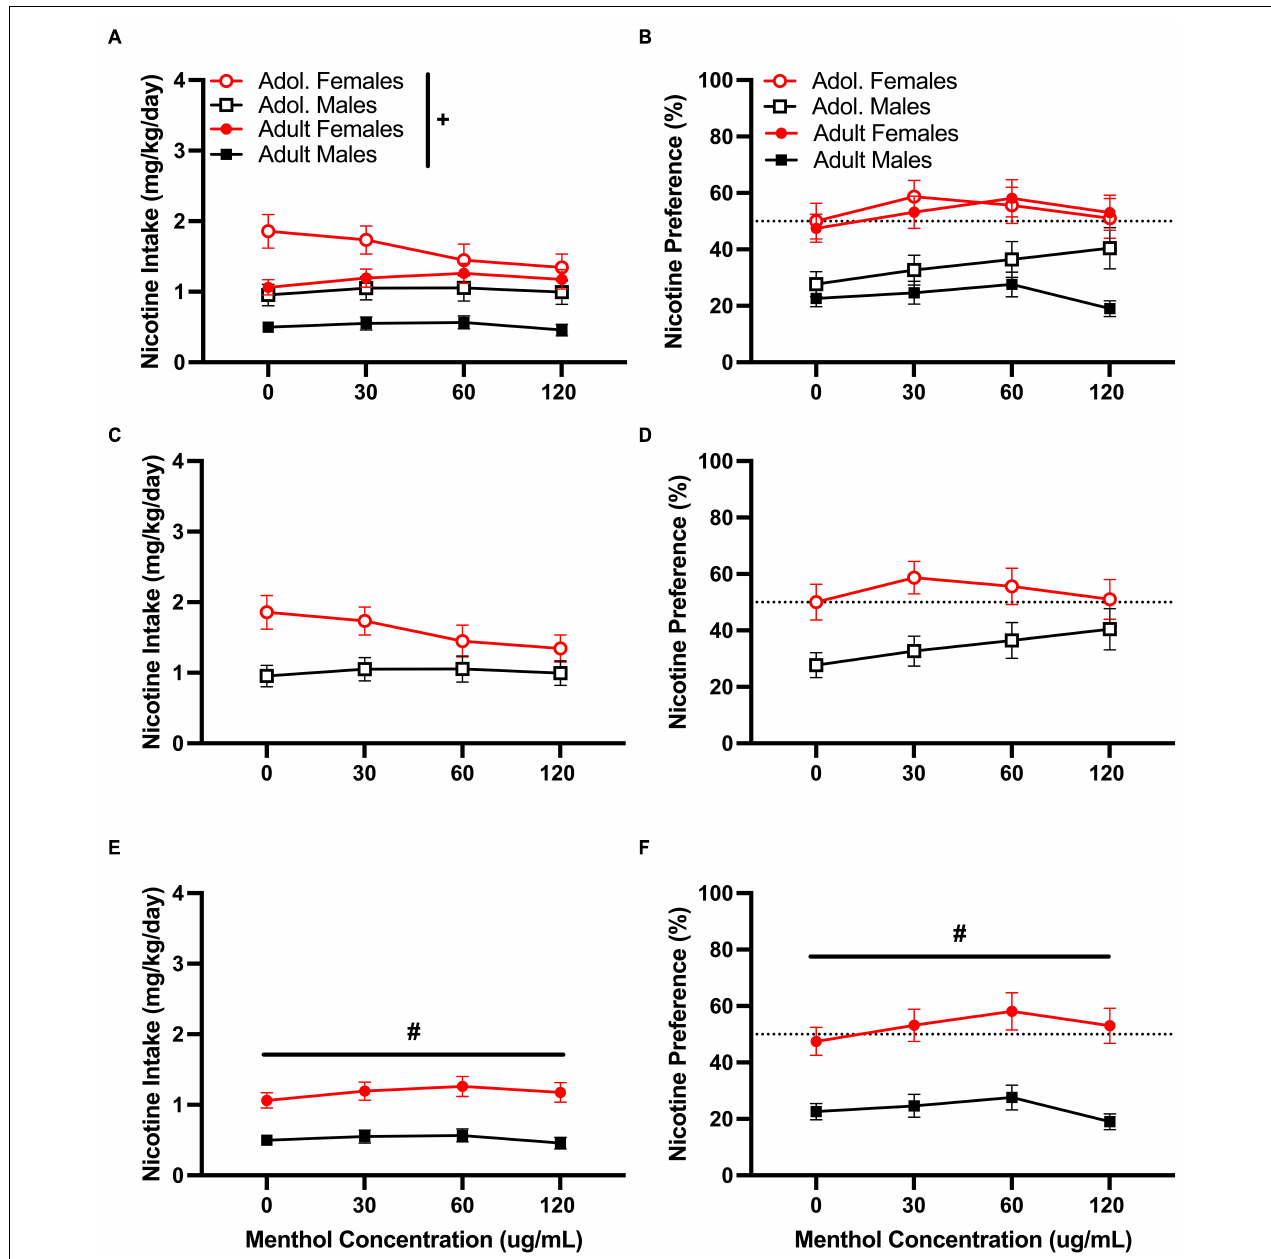
FIGURE 2 | Effects of menthol on oral nicotine (10 µ g/mL) consumption in adult and adolescent male and female DBA/2J mice. Mice were given a choice of DI water or menthol + nicotine [nicotine (10 µ g/mL) + menthol 0–120 µ g/mL] in a within-subject manner in the two-bottle choice paradigm. Intake is calculated as mg of drug per kilogram (mg/kg) of body weight and preference as the volume of drug solution consumed as a percentage of the total fluid consumed. (A,C,E) Average nicotine intake (mg/kg/day) and (B,D,F) nicotine preference (%) are shown. Data are presented as the mean ± SEM of 10–15 mice/sex/age. Results are based on a RM three-way ANOVA with age, sex, and menthol concentration as factors. + P < 0.05 vs. adults. * P < 0.05 vs. 0 µ g/mL. # P < 0.05 vs. males.